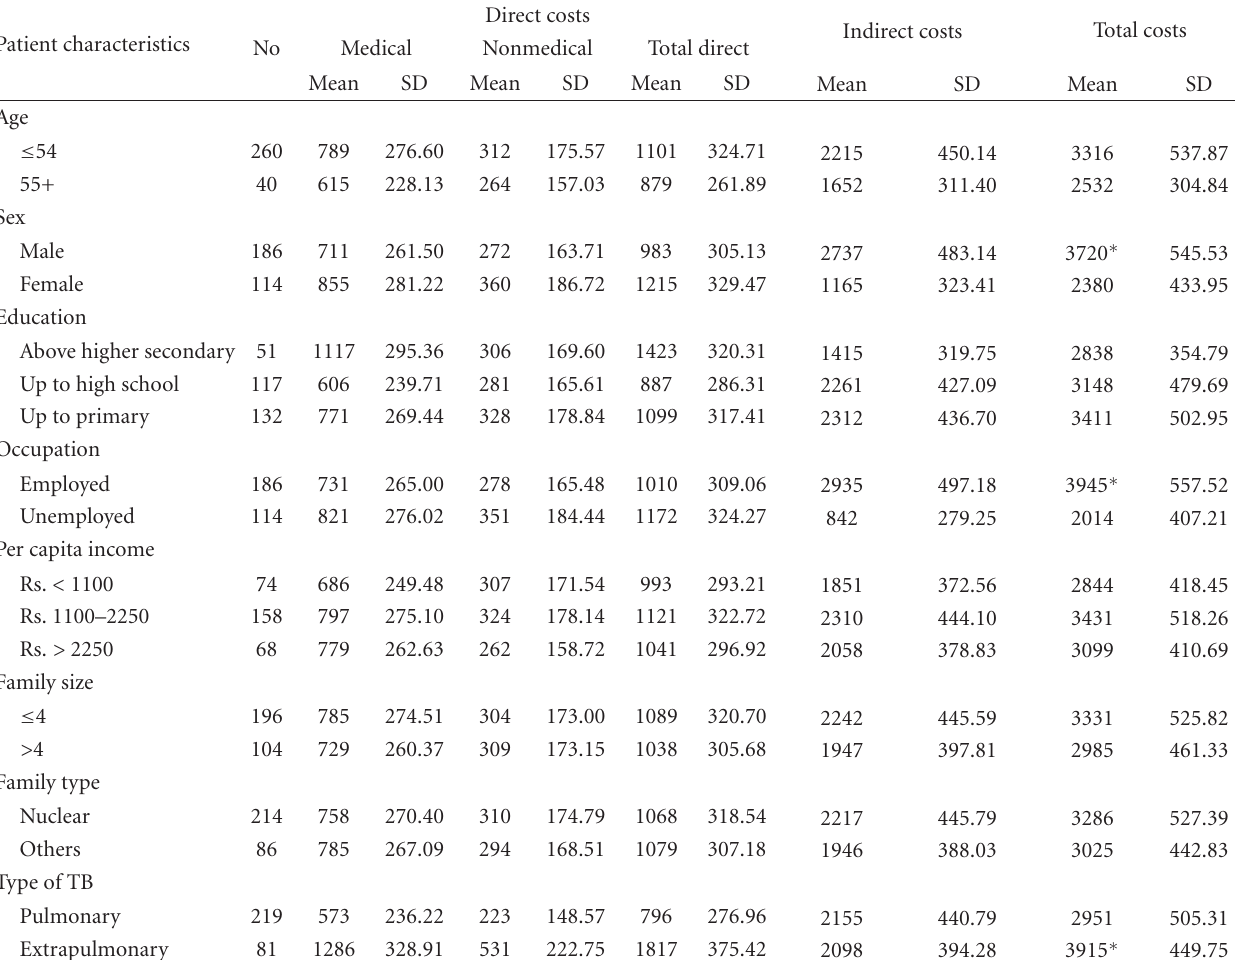
Table 1: Overall mean direct (medical and nonmedical), indirect, and total costs according to patient demographic and socioeconomic characteristics.